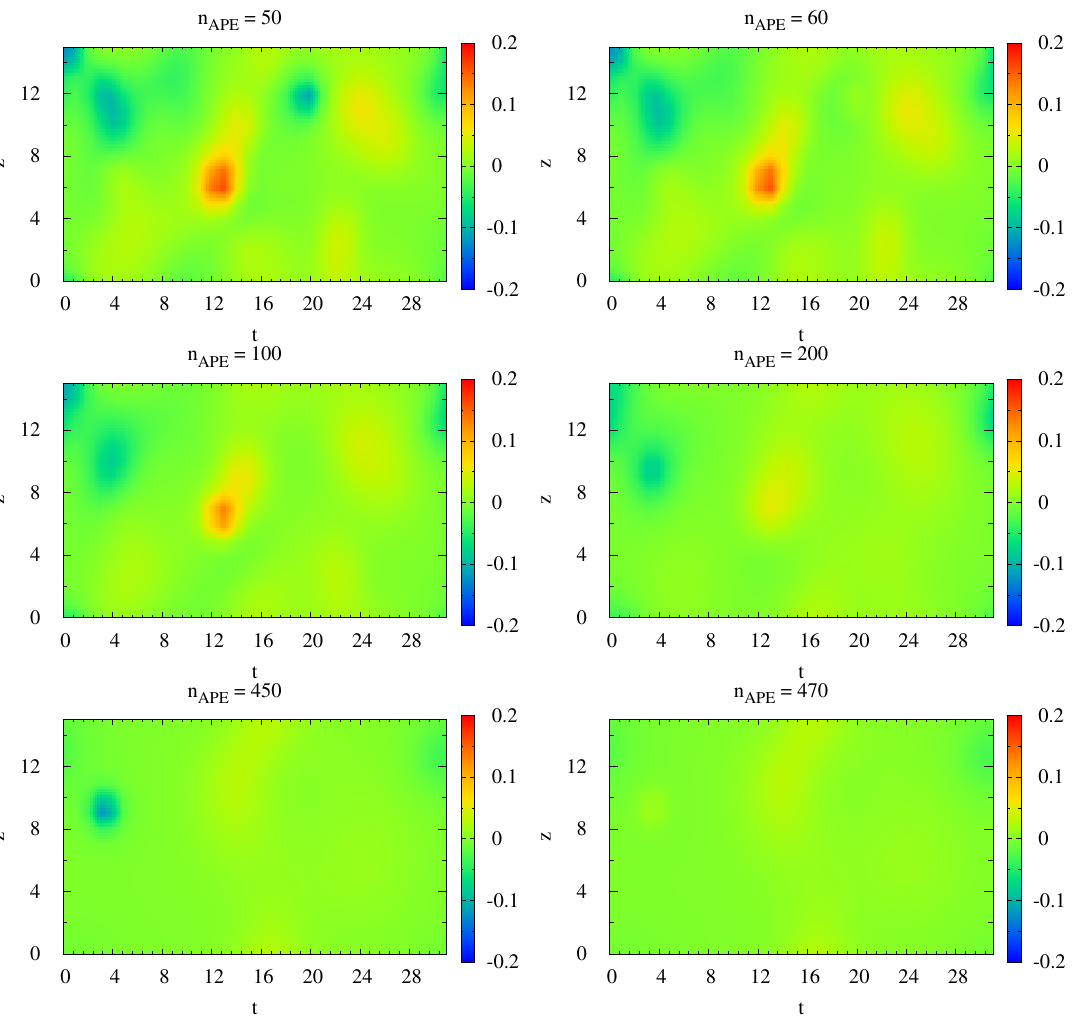
Figure 4 . Distribution of topological charge projected onto z - t plane at n APE = 50 , 60, 100, 200, 450, and